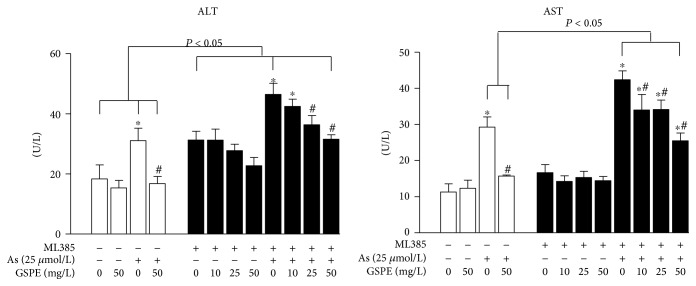
Effects of arsenic and/or grape seed procyanidin extract on liver function after Nrf2 inhibition. After Nrf2 inhibition, L-02 cells were treated with arsenic and/or grape seed procyanidin extract for 24 h. ∗Compared with the control group, P < 0.05; #compared with the arsenic group, P < 0.05. After Nrf2 inhibition, high-dose GSPE could still reduce ALT and AST levels compared with the arsenic group, but the reducing effect of GSPE on arsenic-induced ALT and AST levels was weak.